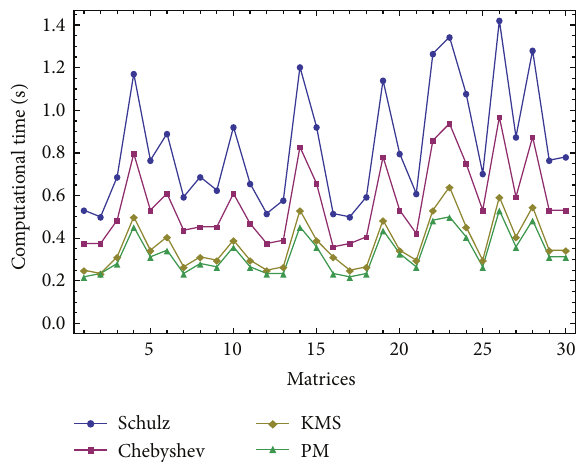
Figure 3: The results of comparisons for Experiment 1 in terms of the elapsed time using ‖𝑉 𝑛+1 − 𝑉 𝑛 ‖ 𝐹 ≤ 10 −6